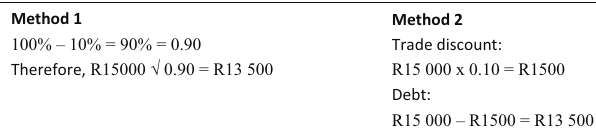
FIGURE 4: Solution trade discount.